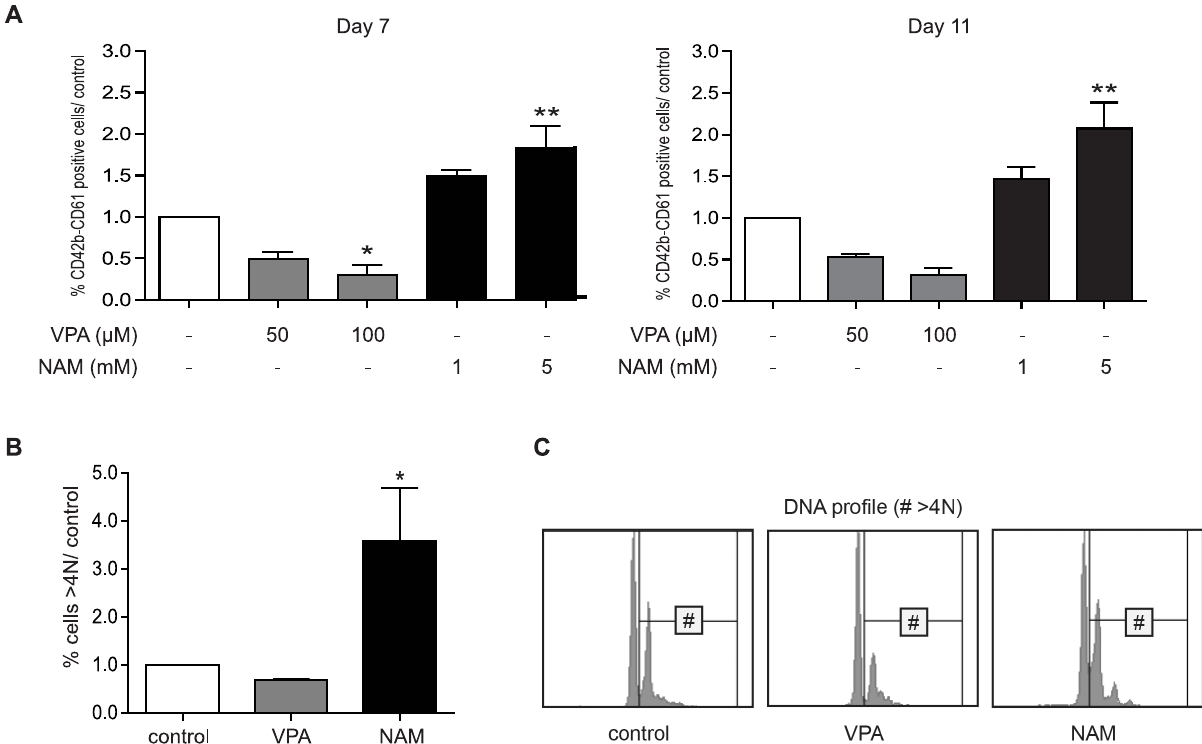
Fig 2. VPA and NAM have opposing effects on megakaryocyte differentiation. UCB-derived CD34+ cells were differentiated towards megakaryocytes for 11 days in the absence or presence of 100–200μM VPA, or 1-5mM NAM. (A) At day 7 and 11 of differentiation surface expression of CD61 and CD42b was analysed by FACS. Data represent the percentage of double positive cells, compared to the control. (B) At day 11 of differentiation, cellular DNA content was analysed by FACS. Data represent the percentage of polyploid cells ( > 4N), compared to the control within the CD42b positive population (left panel), and FACS histogram plots of DNA profile (right panel). Data are representative for 3 independent experiments. Error bars represent SEM, (cid:3) p < 0.05, (cid:3)(cid:3) p < 0.01.